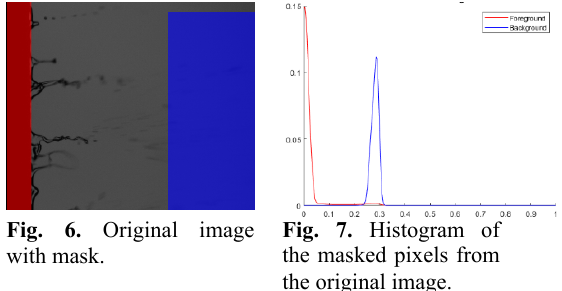
Fig. 6. Original image with mask.